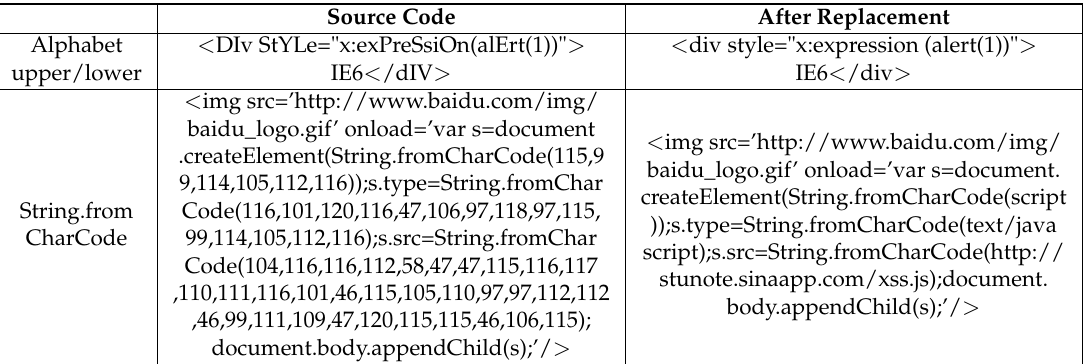
Table 4. Equivalent Replacement Example for XSS Payload.